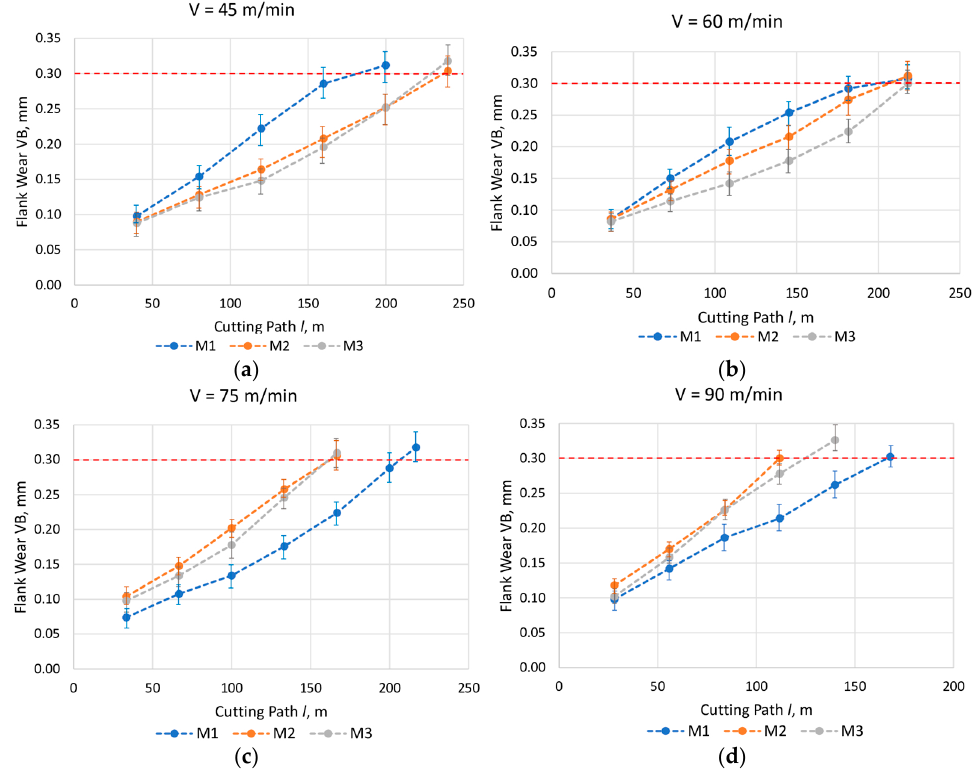
Figure 2. Results of the comparative tests focused on the wear resistance of the tools with the coatings under study in turning a nickel-based alloy at cutting speeds of ( a ) 45, ( b ) 60, ( c ) 75, and ( d ) 90 m/min. The red dotted line indicates the value of limit wear on the flank face VB max = 0.3 mm. The patterns of wear and fracture on the coatings under consideration after cutting were considered. Lamellas, cut from the area of the coating fracture boundary on the wear crater boundary farthest from the cutting edge, were selected for the study (see Figure 3).